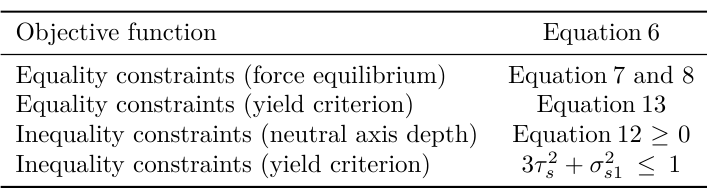
Table 1. List of constraints for optimisation.